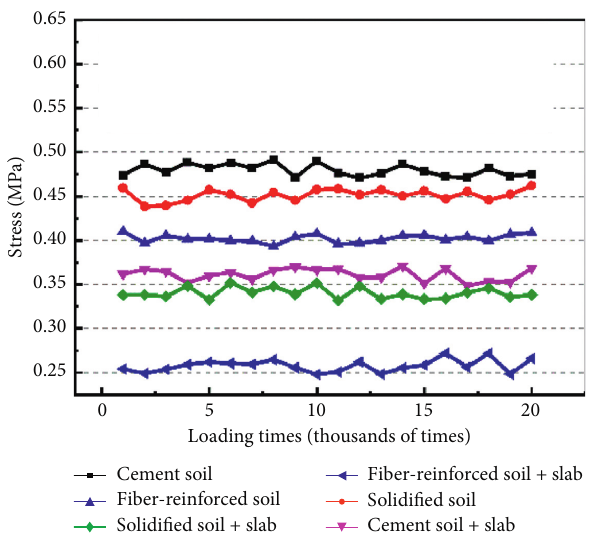
Figure 18: Relationship between the maximum stress at the bottom of base course and the number of loading